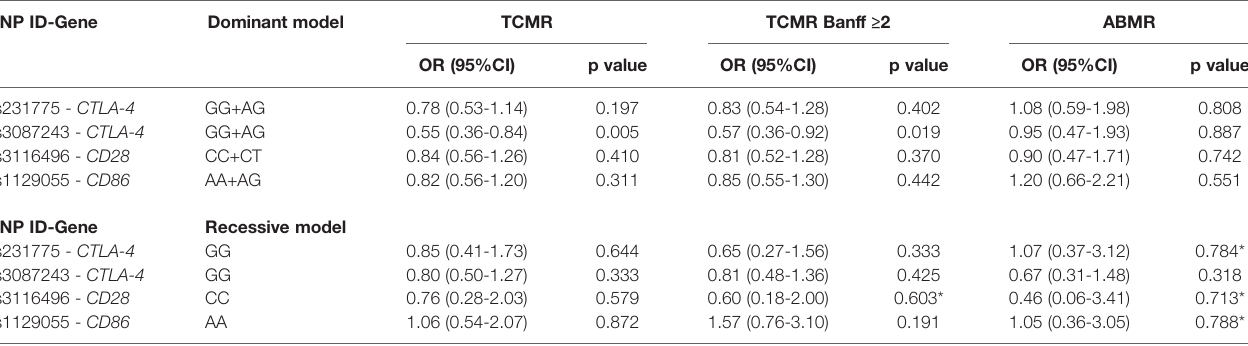
TABLE 1 | Univariate analysis for